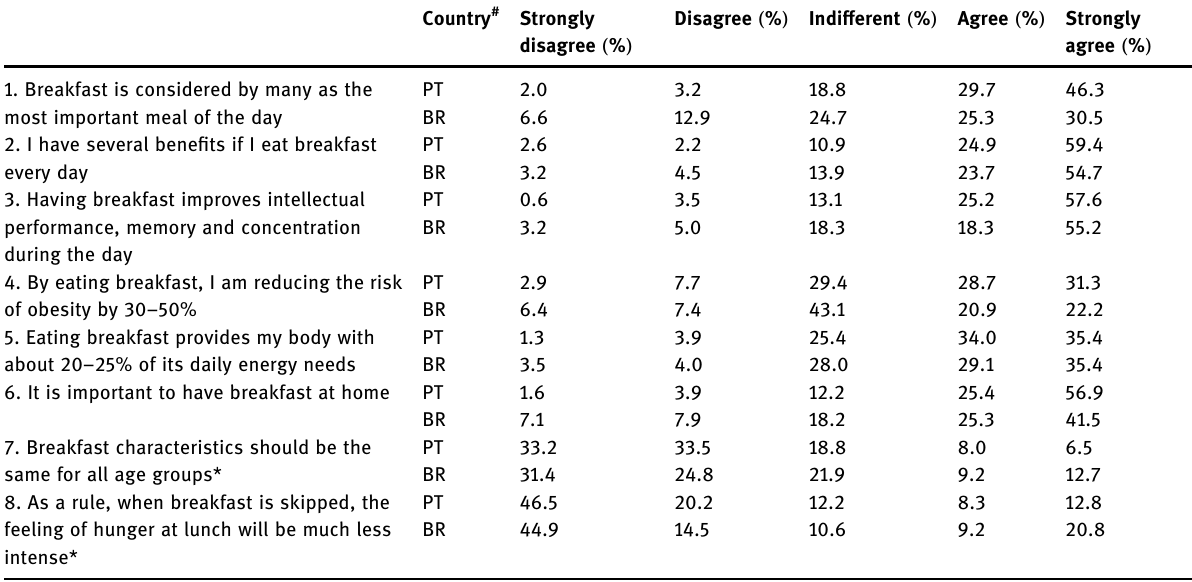
Table 3: Responses to the questions aimed at evaluating knowledge about breakfast Country #